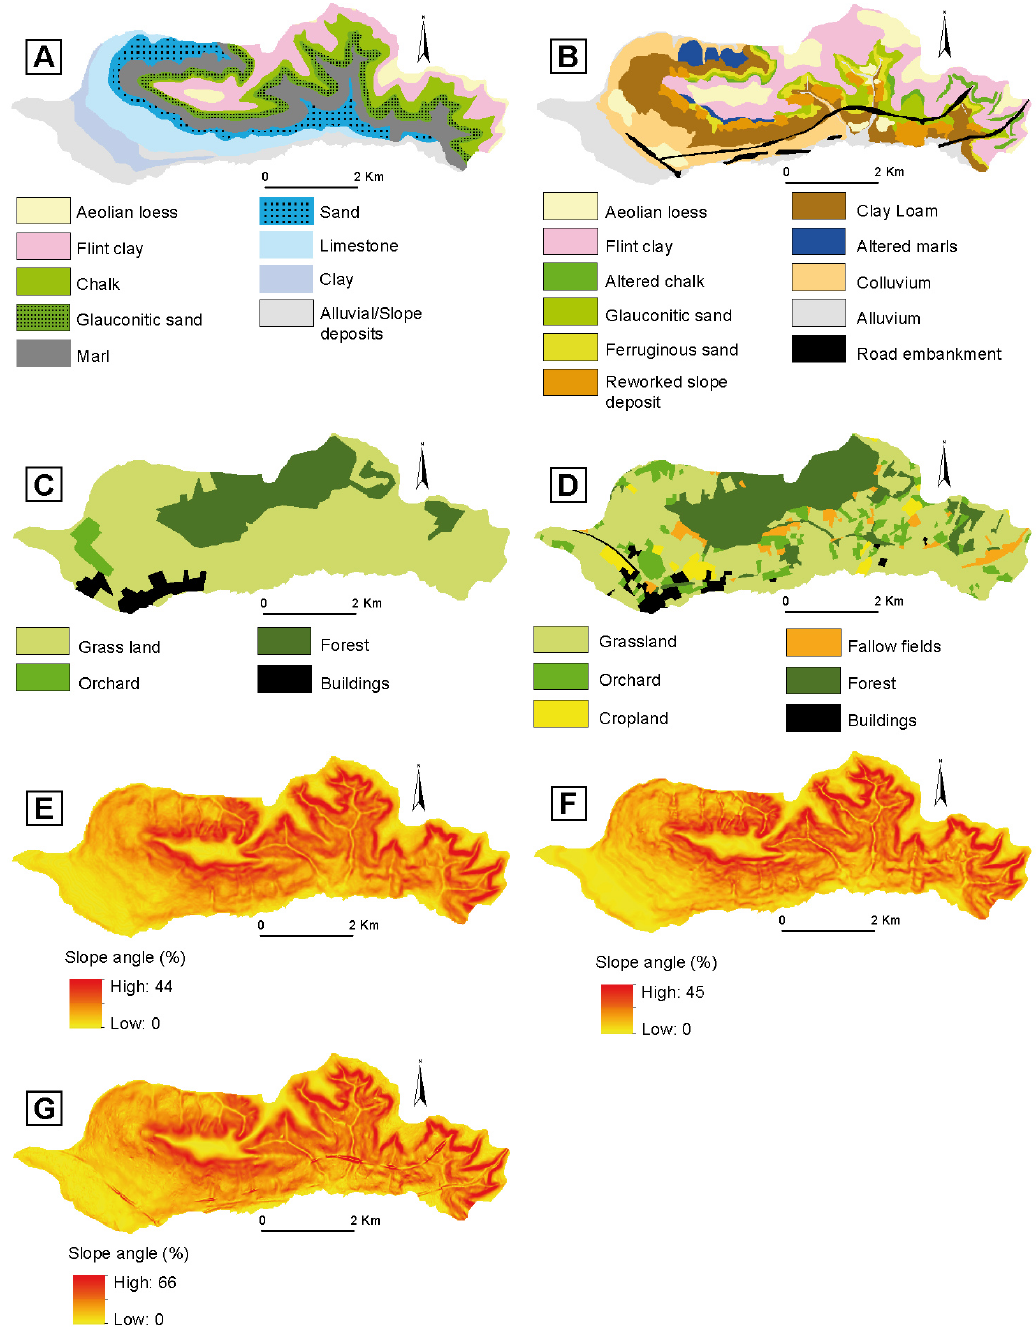
Fig. 6. Comparison of the sets of data available for the three main categories: materials, landuse and topography. (A) 1/50000 scale geo- logical map, (B) 1/10000 scale surficial formations map, (C) 1/100000 scale Corine land cover, (D) 1/5000 scale landuse map, (E) slope map of BDAlti ® DEM, (F) slope map of the DEM extracted from the digitalised contour lines and (G) slope map of the radar